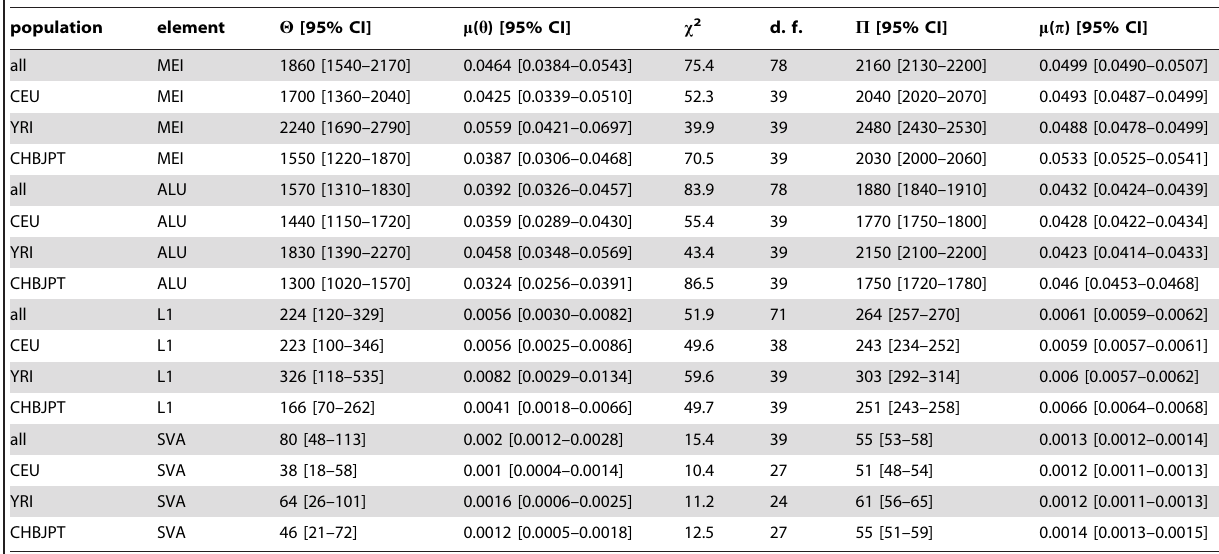
Table 4. MEI population